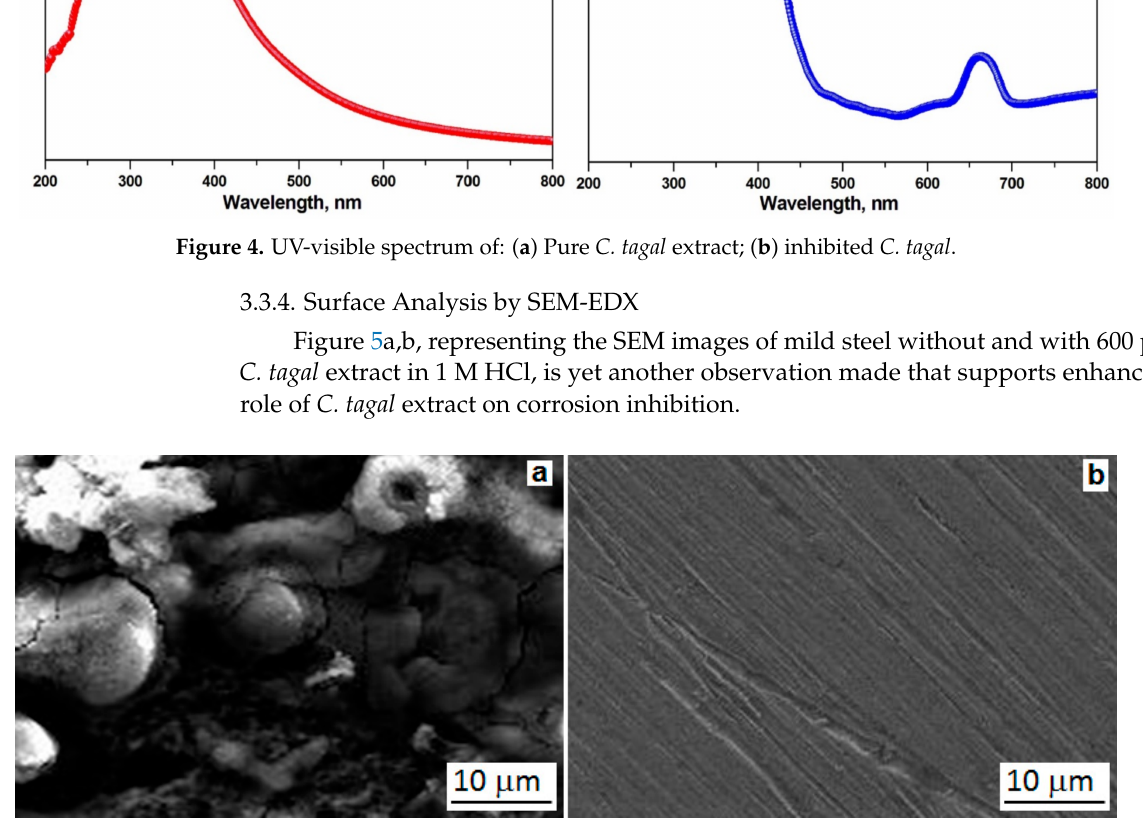
Figure 5. SEM photographs of mild steel dipped in: ( a ) 1 M HCl; ( b ) 1 M HCl with 600 ppm of inhibitor.